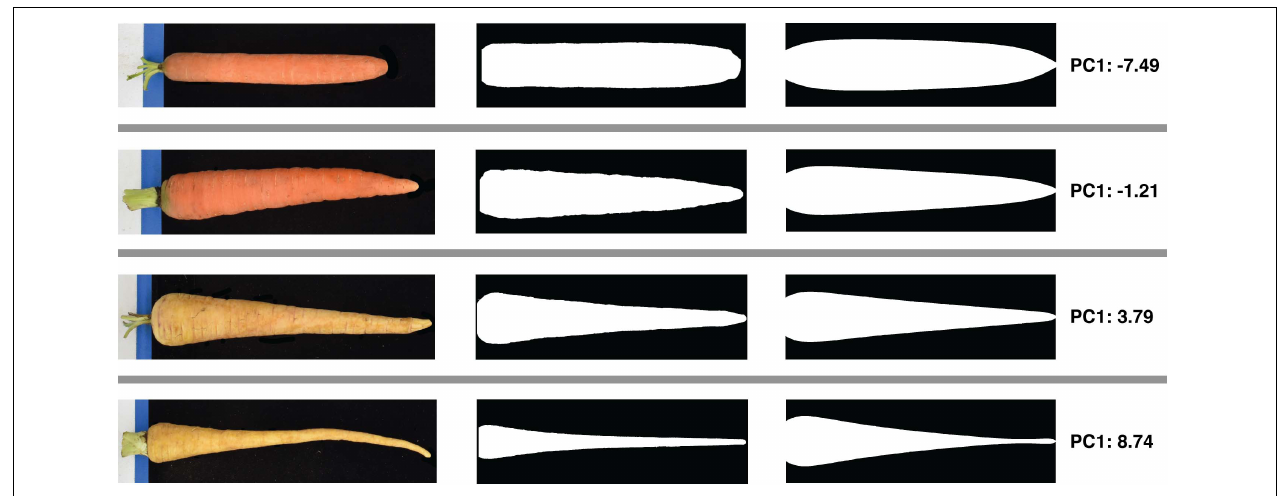
FIGURE 3 | Quantification of size-independent variation in carrot root shape using PCA of length- and width- normalized contours. All carrots were standardized to a maximum width of 1 and a length of 1,000, and contours were decomposed into five principal components. Rows correspond to four representative roots sampled from each quartile of the range of scores along the first principal component, and illustrate the nature of the phenotypic variance captured by this first component. From left to right: raw color photos of roots taken during image acquisition; straightened binary masks of the corresponding root; simulated root profiles generated by taking the product of the first PC score pertaining to this root (far right) and the mean of all other PC scores with the transpose of the eigenvectors generated during eigendecomposition. These simulated profiles demonstrate that variation along the first principal component reflects the degree of root fill, or extent to which a carrot preserves its maximum width down its